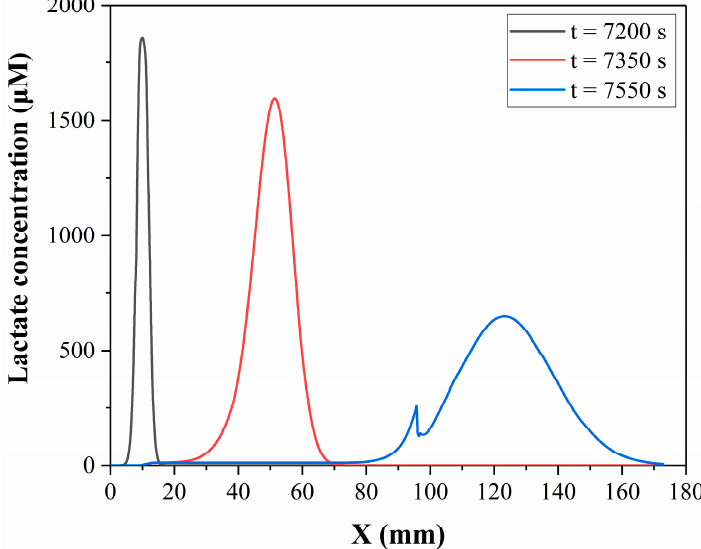
Figure 7. Simulated lactate concentration distribution along the centreline of the microchannel of the micro fl uidic chip at di ff erent times.